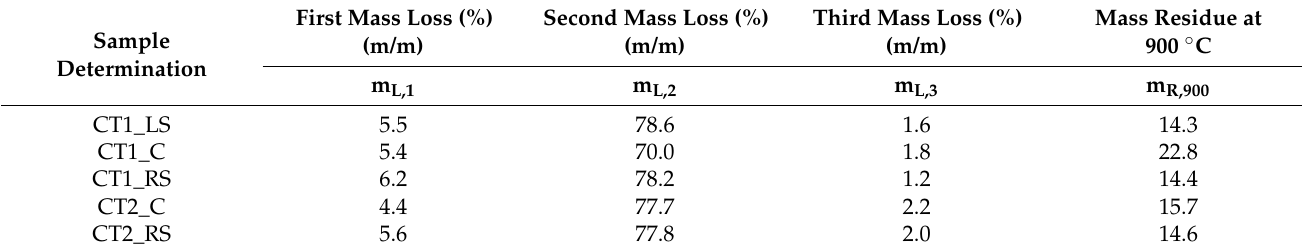
Table 2. Sample mass loss determined during TGA and sample mass residue at 900 ◦